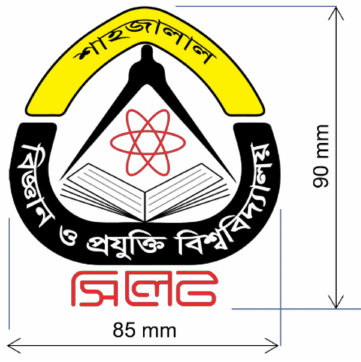
Figure 2. Designed image with the engraved 3D